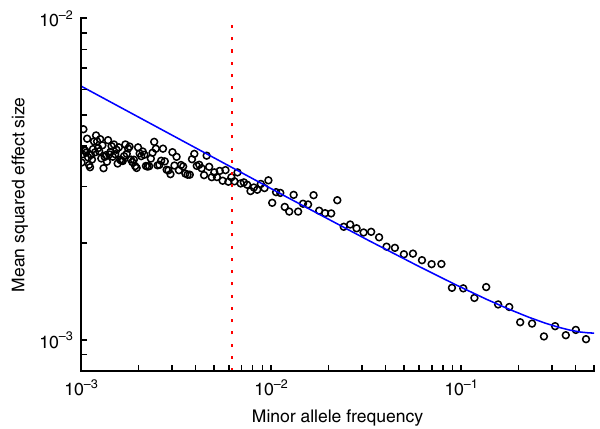
Fig. 2 MAF-dependence of SNP effects in evolutionary forward simulations. Forward simulations con fi rm that α model approximately holds above